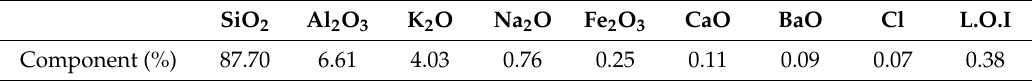
Table 3. Chemical components of